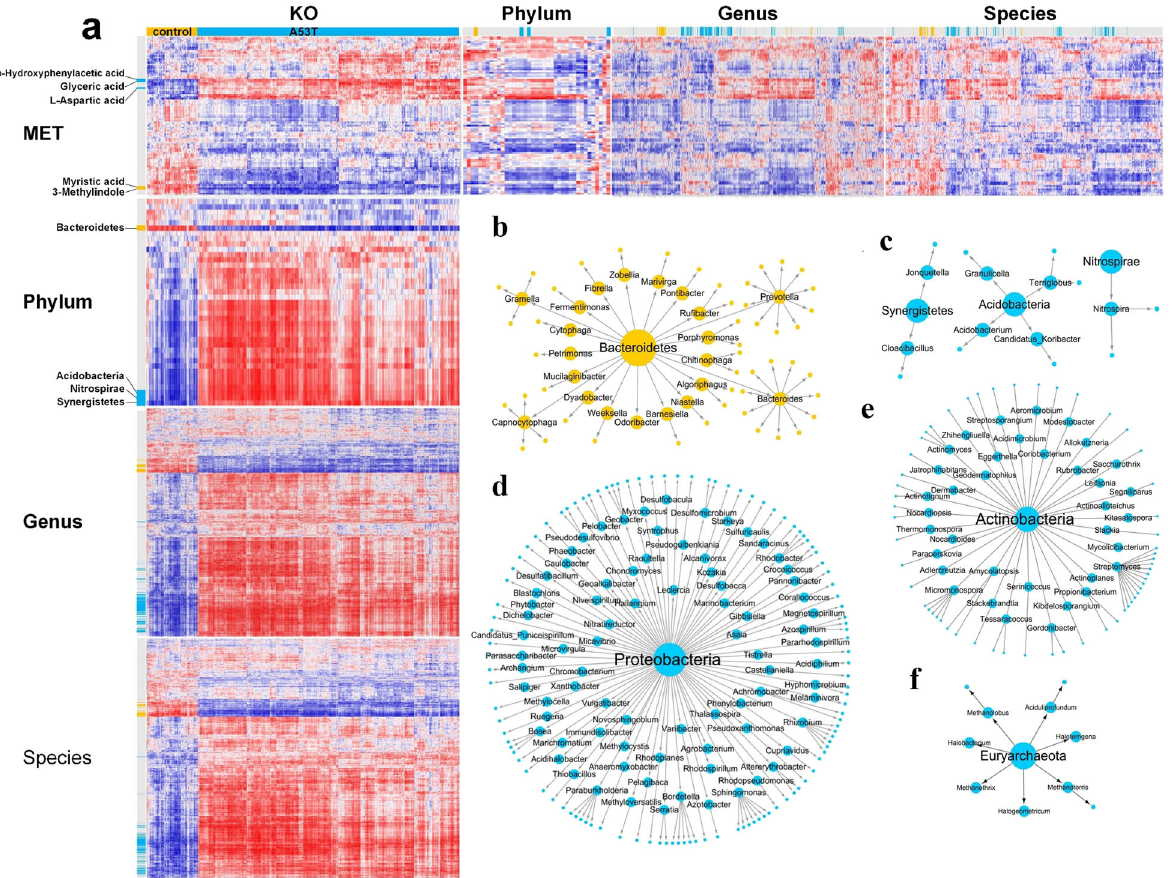
Fig. 3 Integrated analysis of intestinal microbiota and metabolites. a The yellow/blue labels on the left side of the fi gure indicate the microbe showing signi fi cantly different enrichment in the control/A53T group ( p < 0.05). b – g This difference has a distinct transmission relationship in the classi fi cation of part microbe (The direction of the phylum-genus-species is indicated by blue/yellow arrows). Yellow present increased in the A53T group. Blue present increased in the control